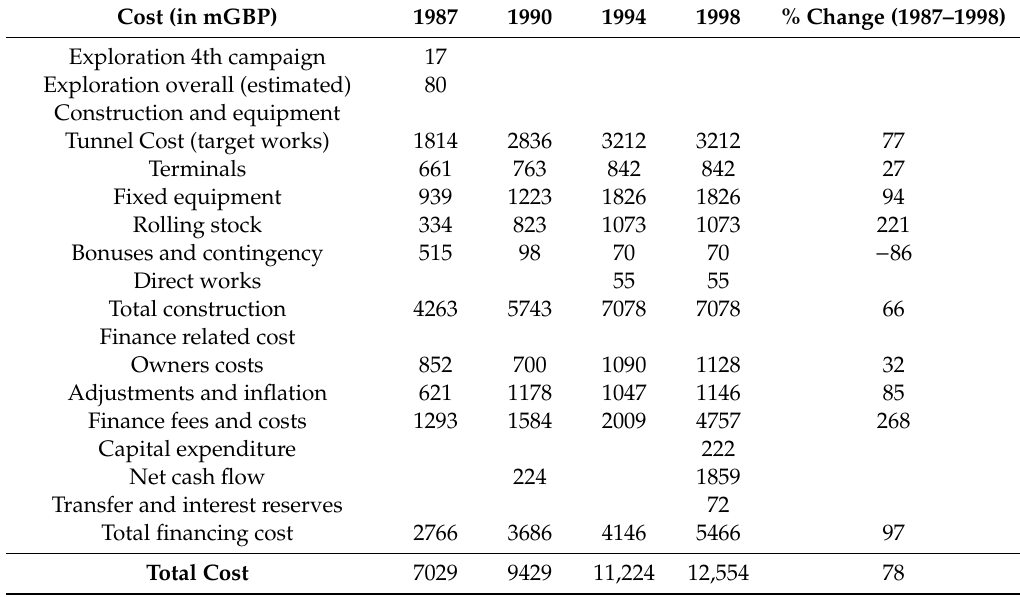
Table 4. Channel tunnel project costs (initial data from: [49]; [44], apart from % change).